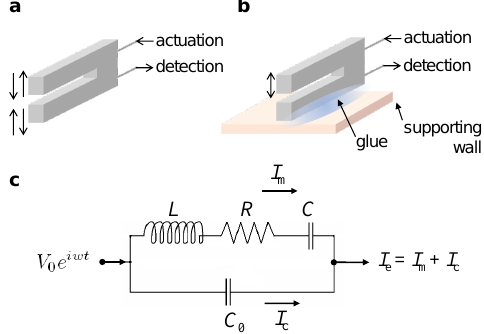
Figure 1. Two working configurations of electrically driven quartz tuning forks and the traditional electrical circuit model for quartz resonators. ( a ) The quartz tuning fork with two prongs can be electrically actuated and its dynamic response can also be measured electrically, where the two prongs move in opposite directions, in an antisymmetric mode of vibration; ( b ) The qPlus sensor is made by fixing one prong firmly to a supporting wall so that the other prong is allowed to vibrate. Both the actuation and the detection of the qPlus can also be made electrically; ( c ) The equivalent circuit model for quartz resonators (e.g., tuning fork,